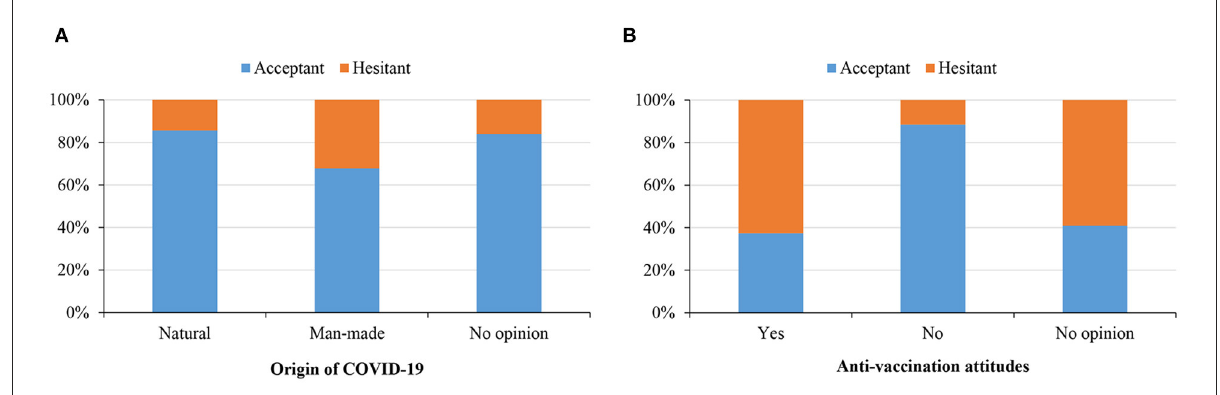
FIGURE4 Willingness to accept vaccine based on the belief in COVID-19 origin (A) and attitude toward anti-vaccination (B) .